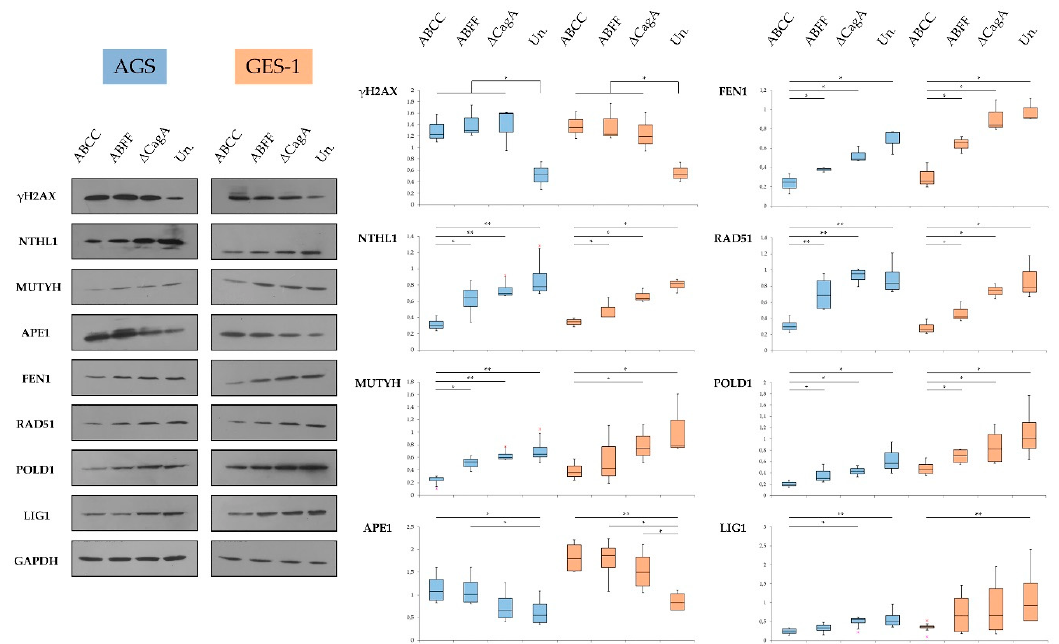
Figure 6. Impact of H. pylori infection ( a ) and CagA protein ( b ) on gene expression of non-homologous end-joining (NHEJ) components, visualized in KEGG pathway map. Components involved in the process are highlighted in red (downregulated) or green (upregulated).